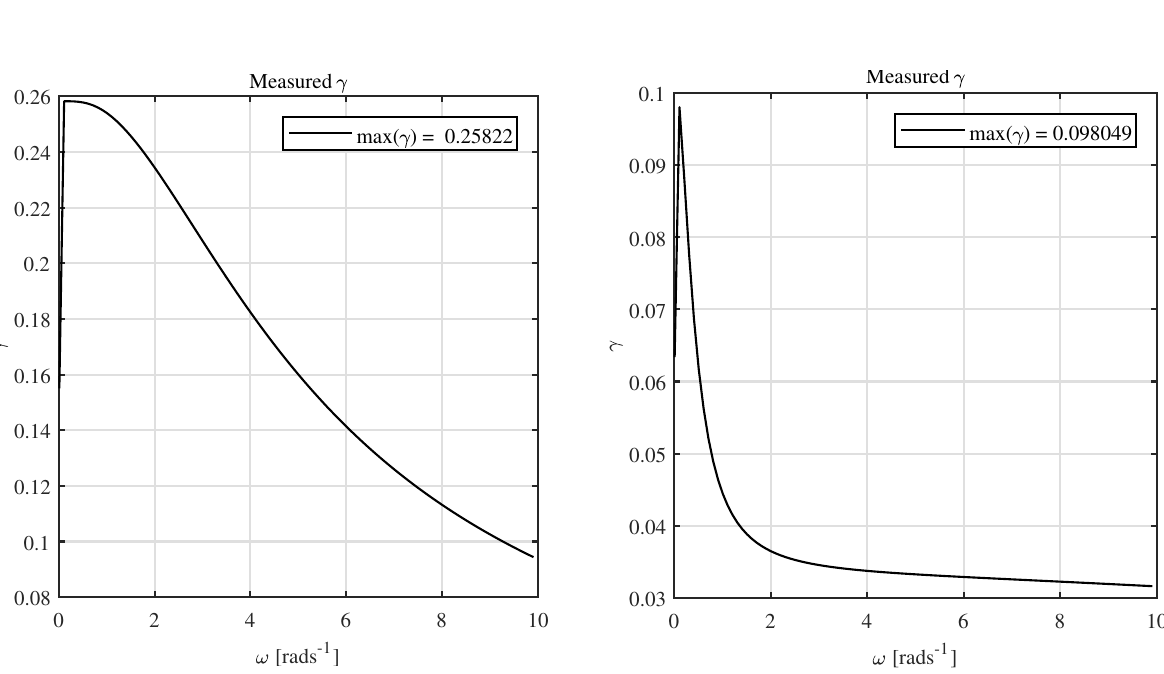
Figure 2: Time response of the controlled output variable.